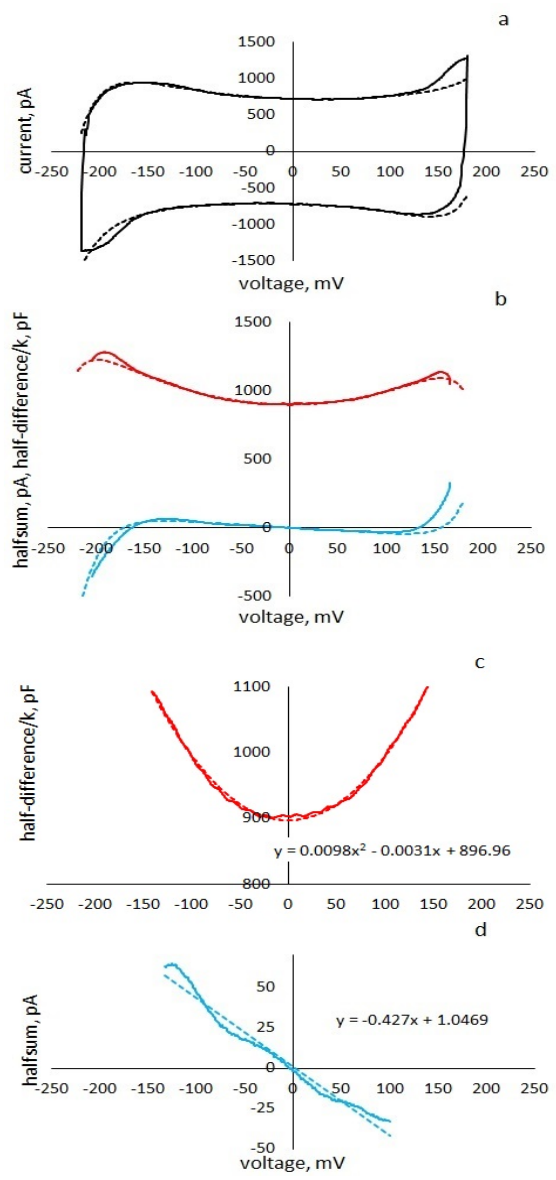
Figure 3. Experimental and theoretical curves of current responses of an azolectin membrane in 0.1 M KCl, to a triangular voltage with an amplitude 200 mV, a frequency 1 Hz (solid curves—experiment, dotted curves—calculation by Formulas (13), (15), (18) and (19): ( a )—cyclic current–voltage characteristic of the membrane; ( b )—half ‐ difference/k—upper curve, half ‐ sum—lower; ( c )—fragment of the capacitance curve and its parabolic fit, ( d )—fragment of apparent negative conductance and its linear fit.